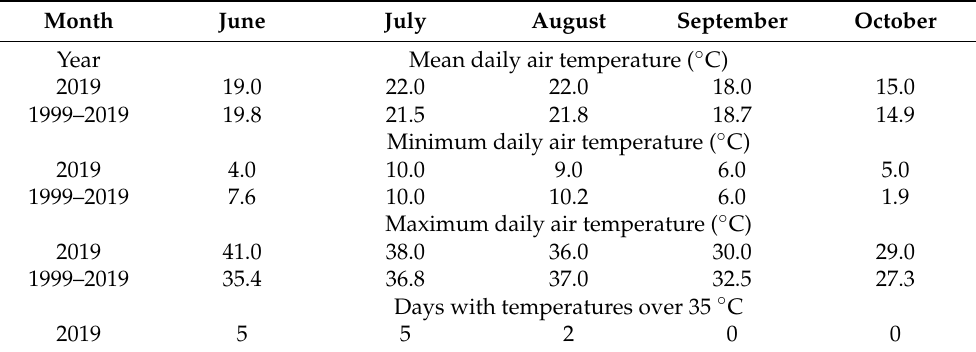
Table 6. Temperature conditions during the growing season of 2019 and the average for the same period in the last 20 years